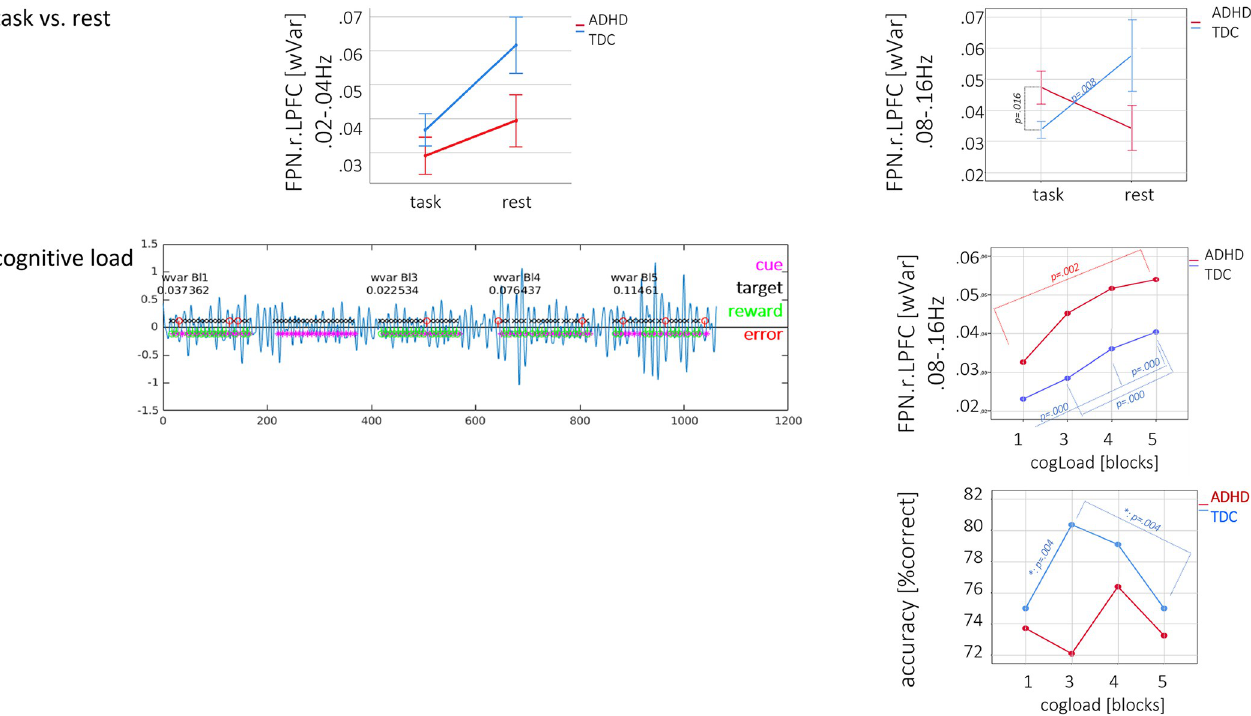
Fig 2. Brain dynamics as measured using wVar. Fig 2 presents differences of wVar between rs-fMRI and task-fMRI (upper row) and the influence of cognitive load on wVar (lower row) at the example of FPN.r.LPFC. Error bars represent